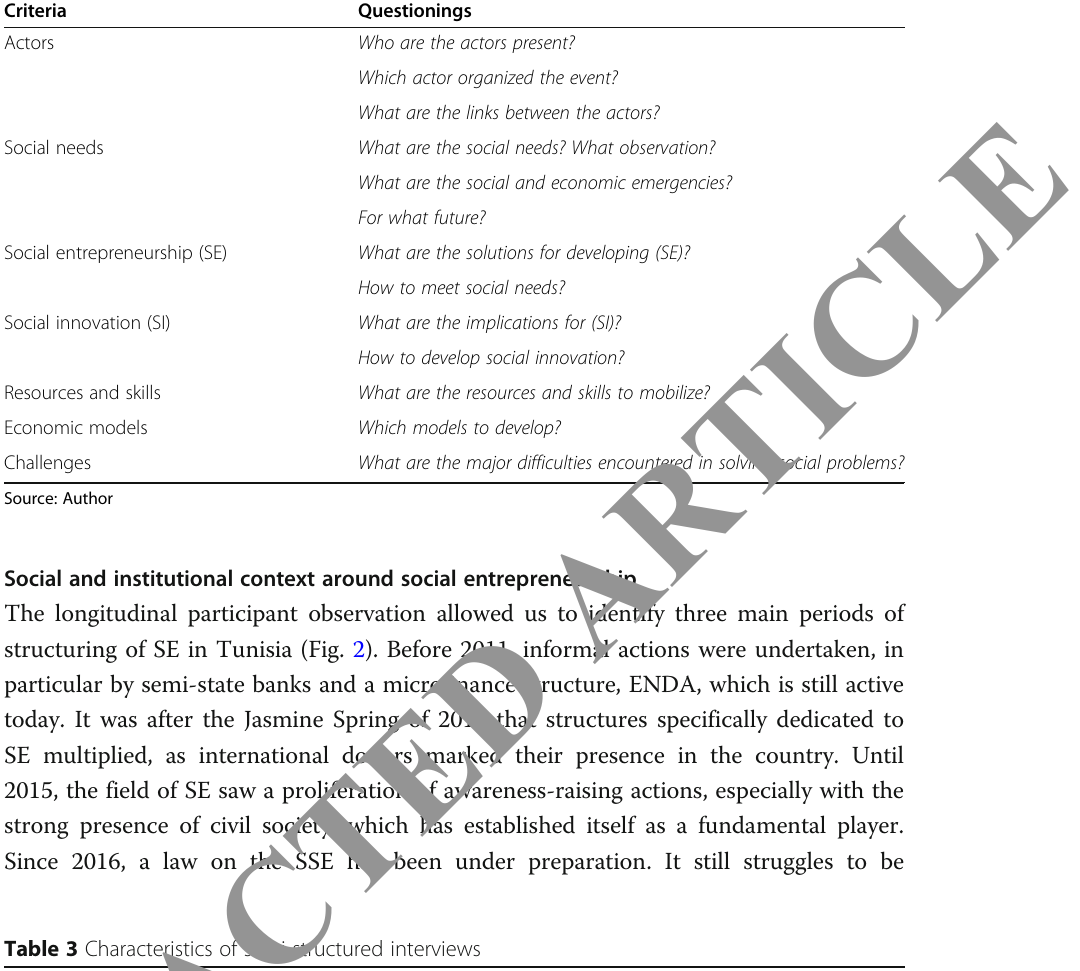
Table 3 Characteristics of semi-structured interviews Social Social enterprise entrepreneurs